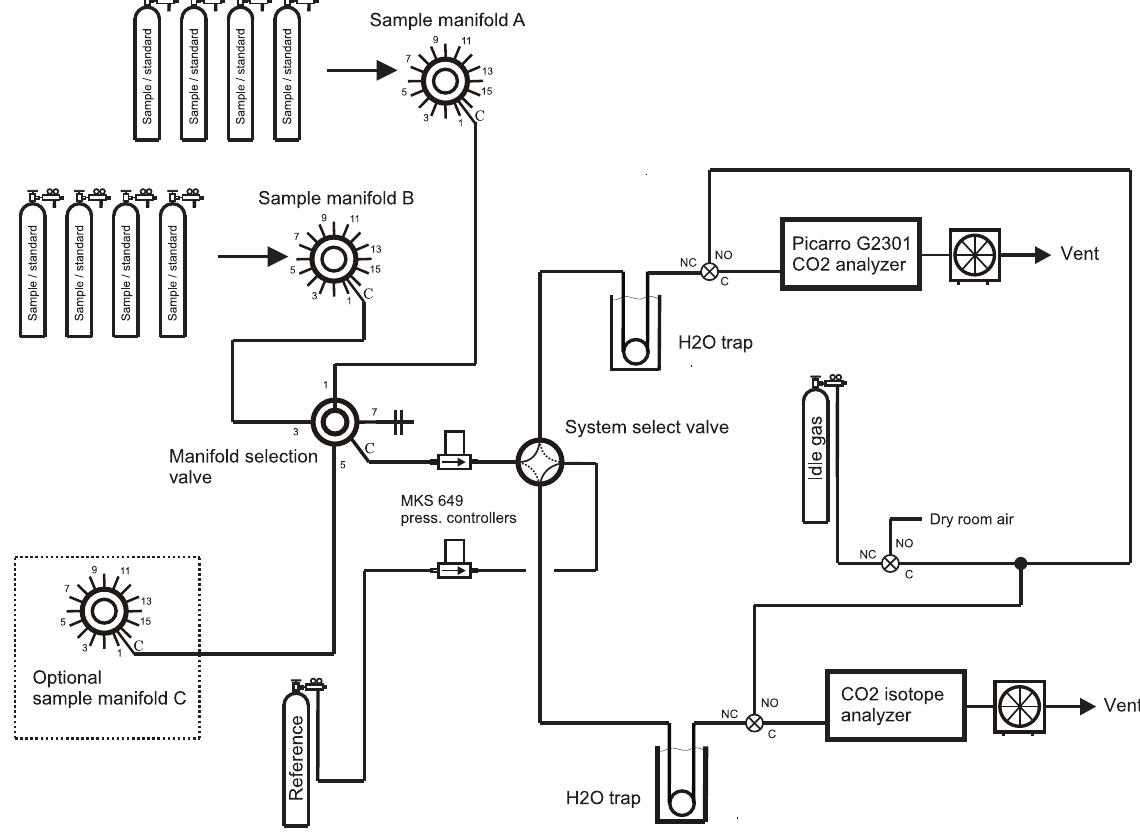
Figure 1. Schematic for the NOAA laser spectroscopic CO 2 calibration system. The CRDS analyzer is used with one of the CO 2 isotope analyzers, which are